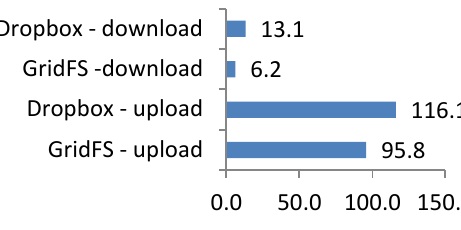
Figure 7: Transfer times for remote transfer.